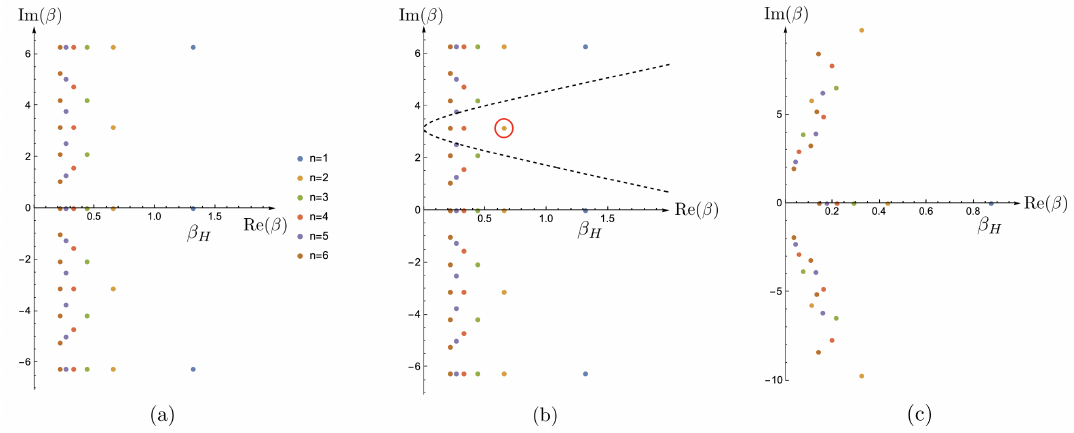
Figure 6 . (a) The distribution of the zeros for the functions { z n ( β ) − 1 | n ≤ 6 } , for the example in (2.5). The zeros have a periodic structure since all the energy eigenvalues are integers. (b) The saddle point that is most important at time t (circled by red) corresponds to the zero rightmost to the hyperbola (2.35), shown in dashed line. (c) The zeros for the example in (2.6). Unlike (a), the zeros now display a bit of